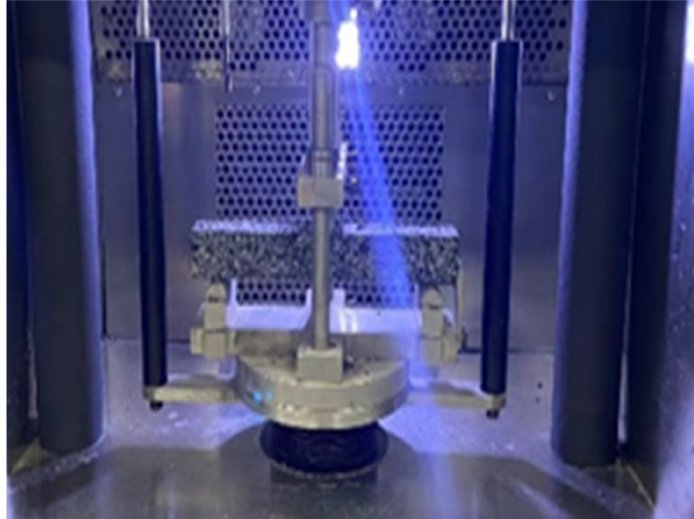
Figure 3. Multifunctional testing machine.